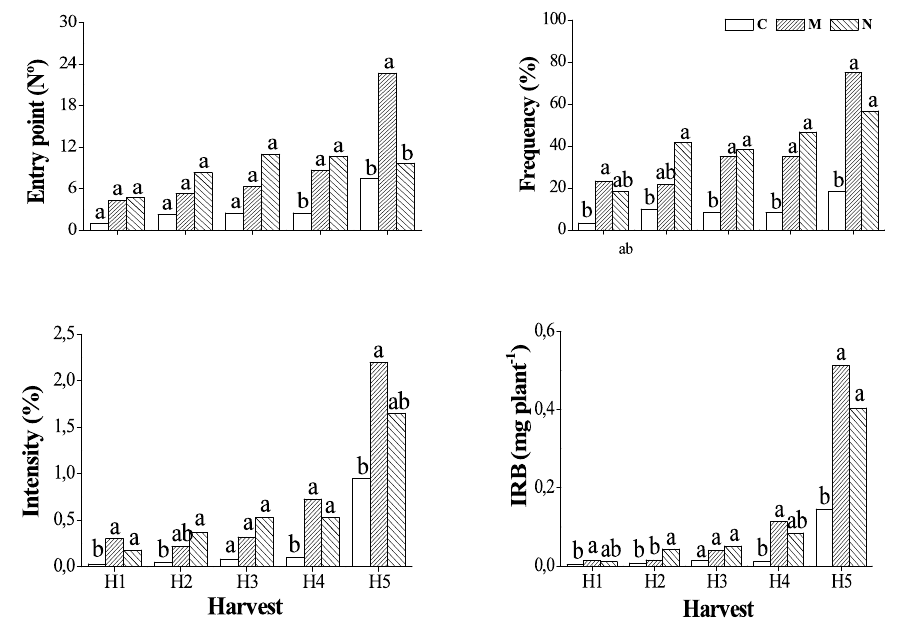
Fig. 3: Mycorrhizal colonization parameters: entry points, frequency of infection, infection intensity, and infected root biomass (IRB) in T. aestivum var. “Kumpa-INIA” with application of Myconate (M), Natural Green (N), and a control (C) without addition NP at 14 (H1), 17 (H2), 20 (H3), 24 (H4), and 29 (H5) days after treatment. Data of each harvest not sharing a letter in common differ significantly according to the Duncan test (P≤0.05). Tab. 2: Plant growth parameters of T. aestivum var. “Kumpa-INIA” with application of Myconate (M), Natural Green (N), and a control without addition of NP (C) at 14 (H1), 17 (H2), 20 (H3), 24 (H4), and 29 (H5) days after